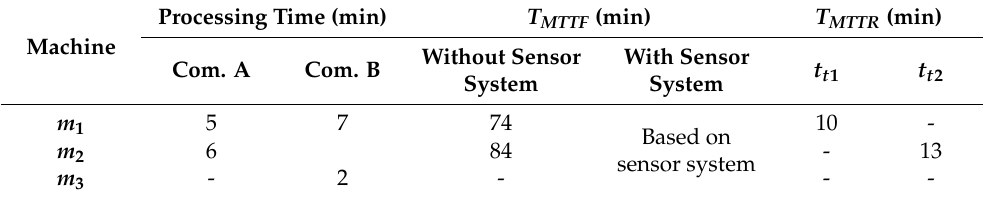
Table 2. Data of the machine maintenance for the model illustrated in Figure 11.